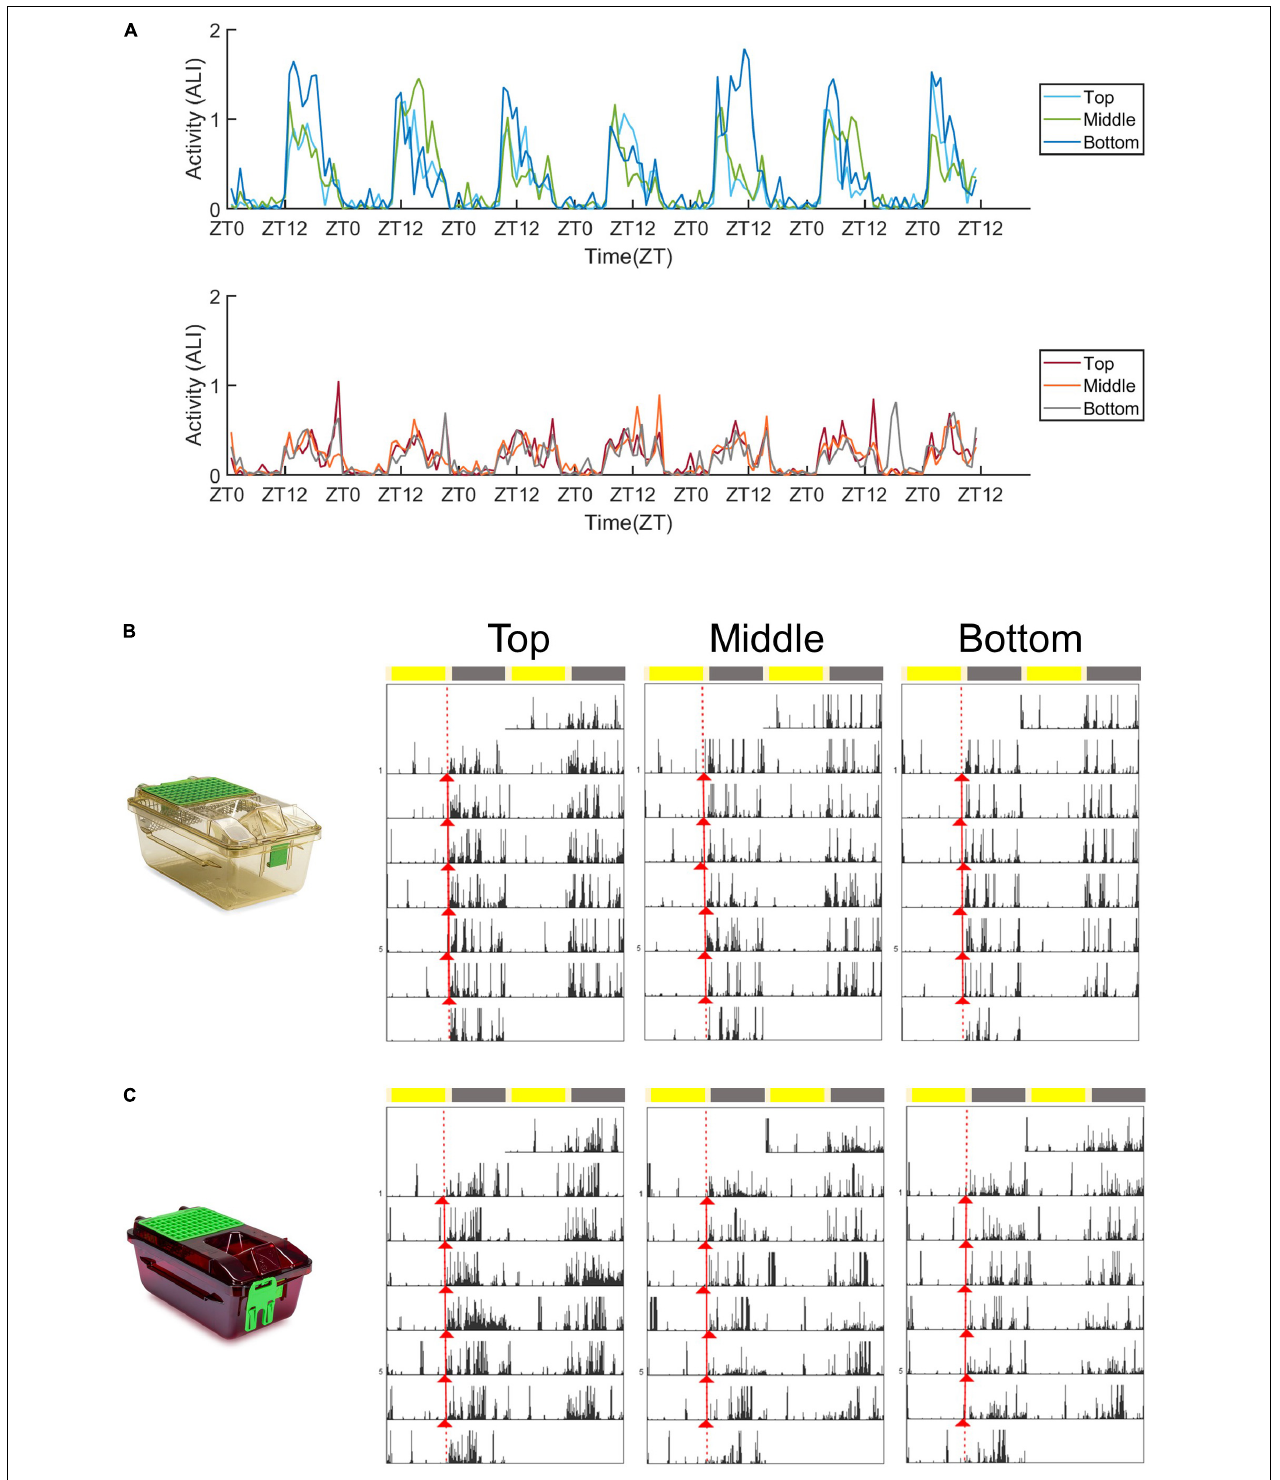
FIGURE 2 | Activity plots and representative actograms. (A) Mean activity (measured as the animal locomotion index) of mice housed in standard cages (top panel) and red cages (bottom panel) across 1 week in the top, middle, and bottom positions. (B) Double plotted actograms (Actogram J) of a representative standard cage housed mouse in the 1 week spent in the top, middle, and bottom positions of the DVC rack. Activity onsets are marked in red (Actogram J). (C) Double plotted actograms (Actogram J) of a representative red cage housed mouse in the 1 week spent in the top, middle, and bottom positions of the DVC rack. Activity onsets are marked in red (Actogram